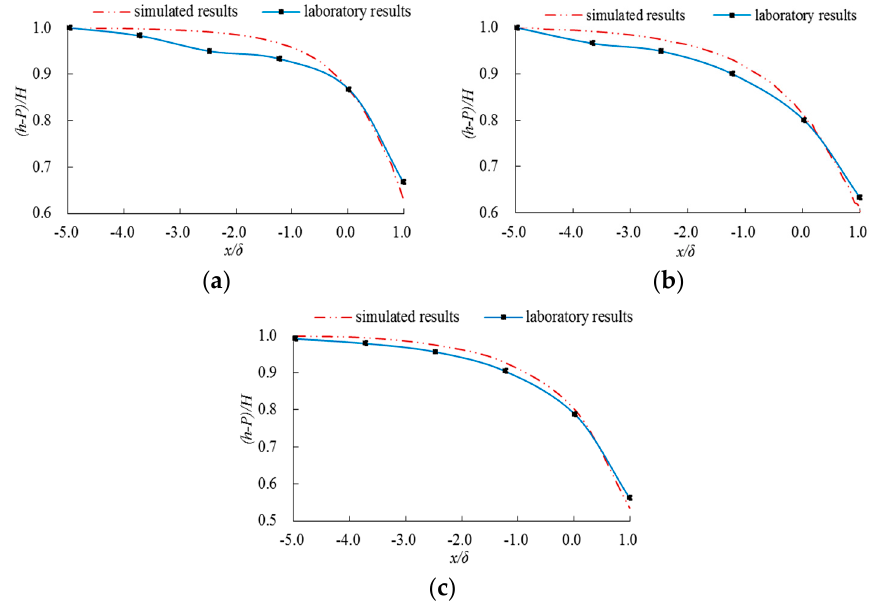
Figure 4. Comparison of free surface profiles between numerical results and laboratory results at ξ = 0.6 for: ( a ) S 1 = 0.0, S 2 = 0.0; ( b ) S 1 = 2.0, S 2 = 0.0; ( c ) S 1 = 2.0, S 2 = 0.8.